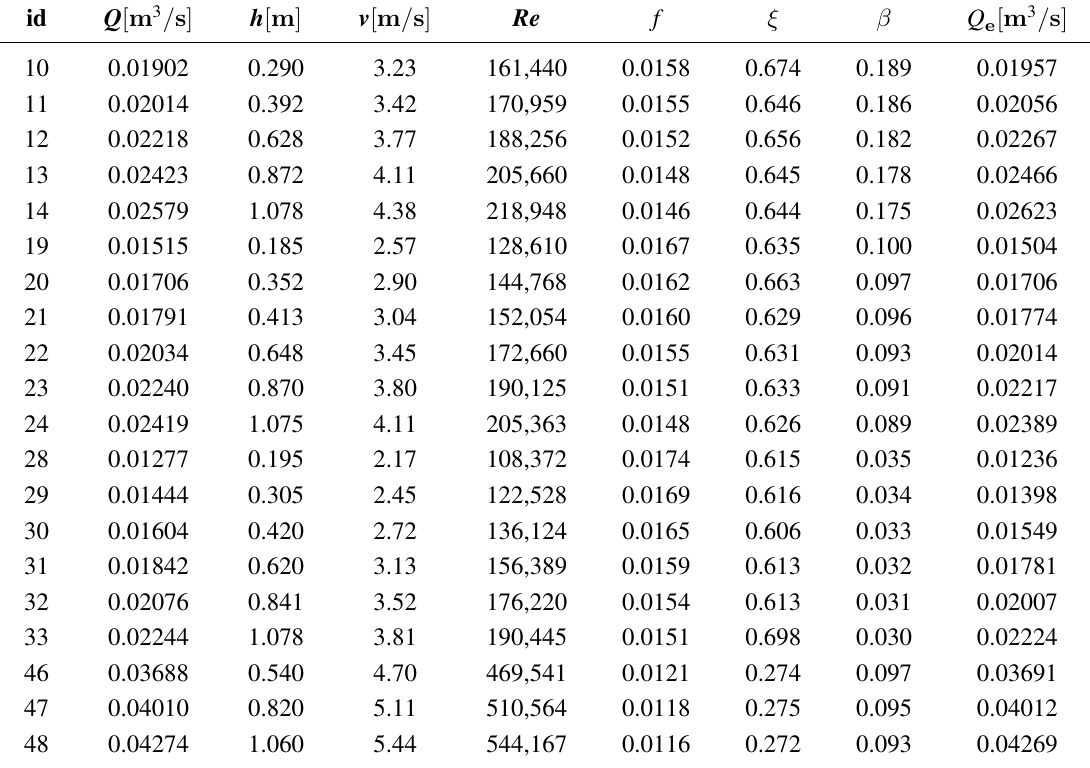
Table 2. Experimental full flow